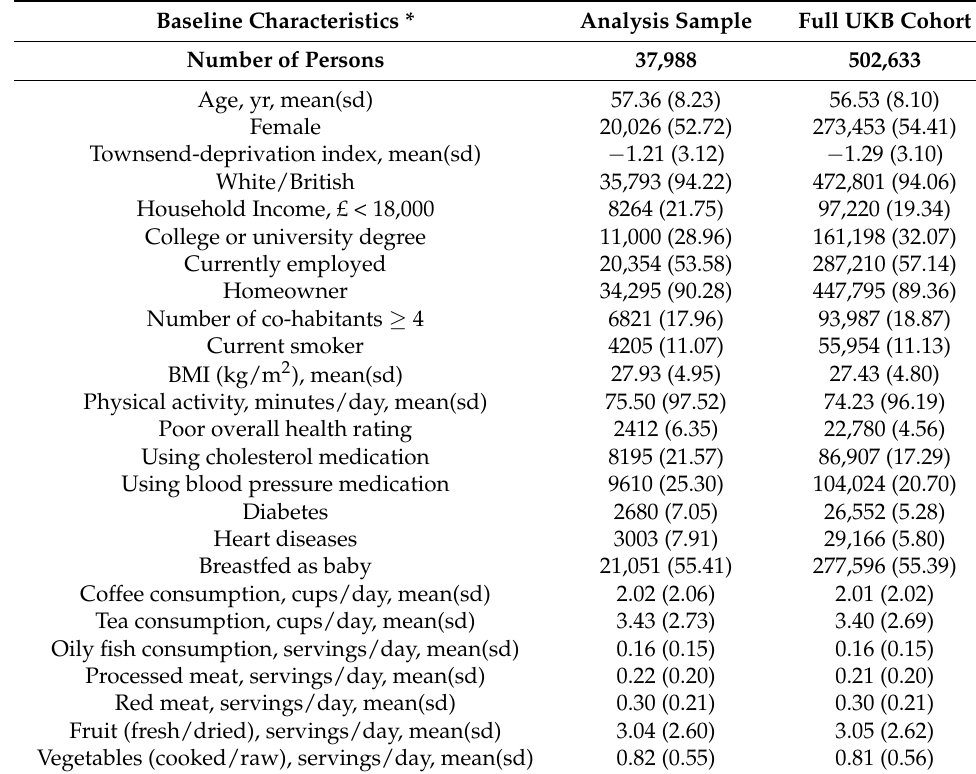
Table 1. Baseline characteristics of the analysis sample and the full UK Biobank